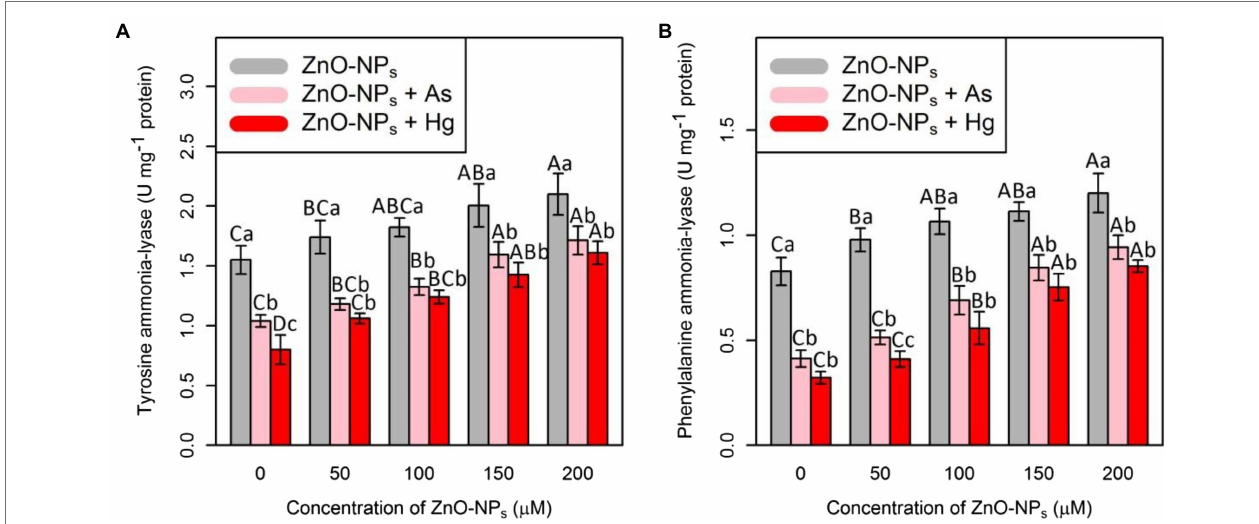
FIGURE 2 | The impact of ZnO-NPs concentrations on (A) tyrosine ammonia-lyase (TAL) activity and (B) phenylalanine ammonia-lyase (PAL) in bamboo species ( Pleioblastus pygmaeus ) with 150 μ M As and 150 μ M Hg. The capital letters indicated statistically significant differences across various concentration of ZnO-NPs alone or in combination with 150 μ M As and 150 μ M Hg (the bars with the same colors), while the lowercase letters indicated statistically significant differences within each level of ZnO-NPs alone or in combination with 150 μ M As and 150 μ M Hg (the bars with different colors) according to Tukey’s test ( p <